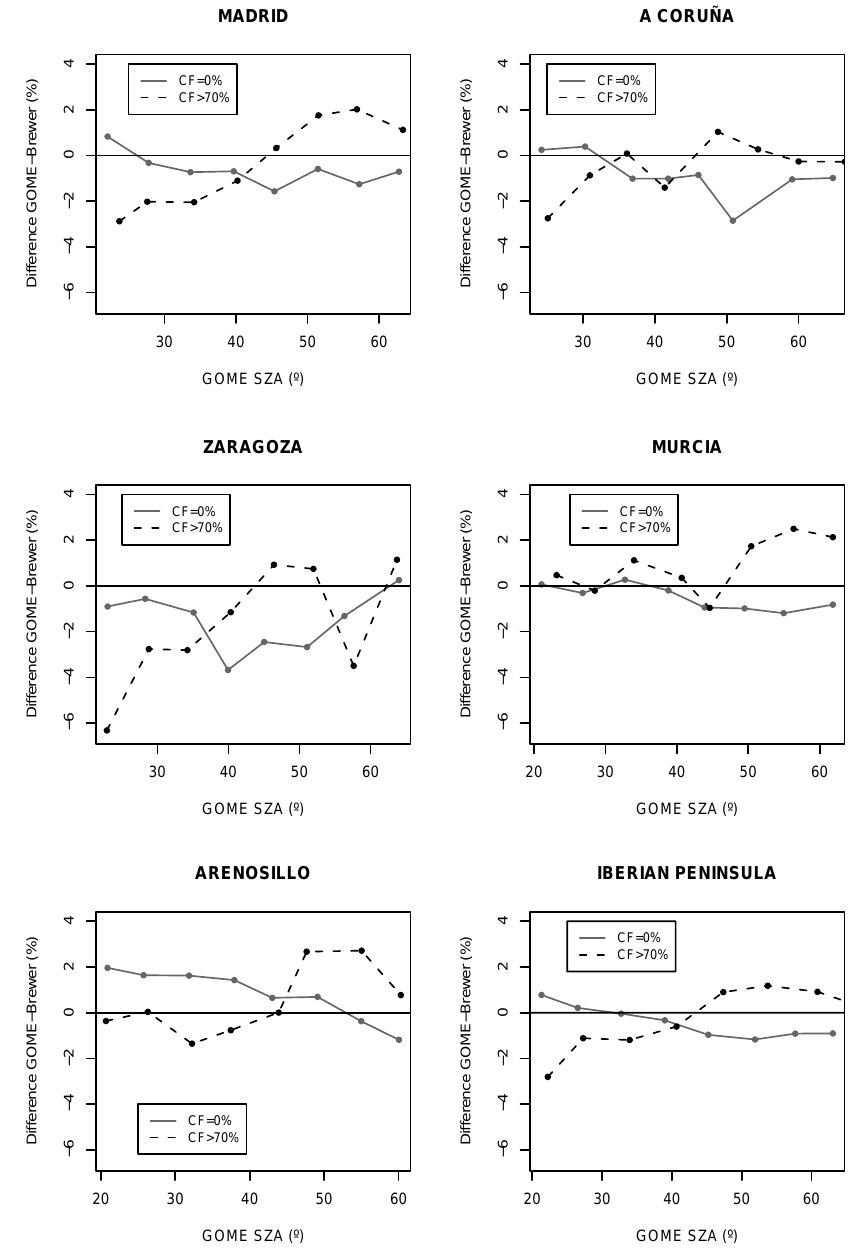
Fig. 5. Variation of GOME-Brewer relative differences with the solar zenith angle for cloud-free conditions and heavy cloud conditions. The temporal evolution of the differences for each station is presented in Fig. 3. The data gaps in the station plots of Murcia and Madrid are due to a lack of reliable Brewer spec- trophotometer data during those periods. From Fig. 3, we can see that the differences between the GOME and Brewer observations are mostly within 10%. The GOME-Brewer differences are generally small in the winter-spring period, while in summer-autumn GOME underestimates ground- based ozone values by 2–4%. On average, this seasonality has an amplitude of 1–2%, which is consistent with previous